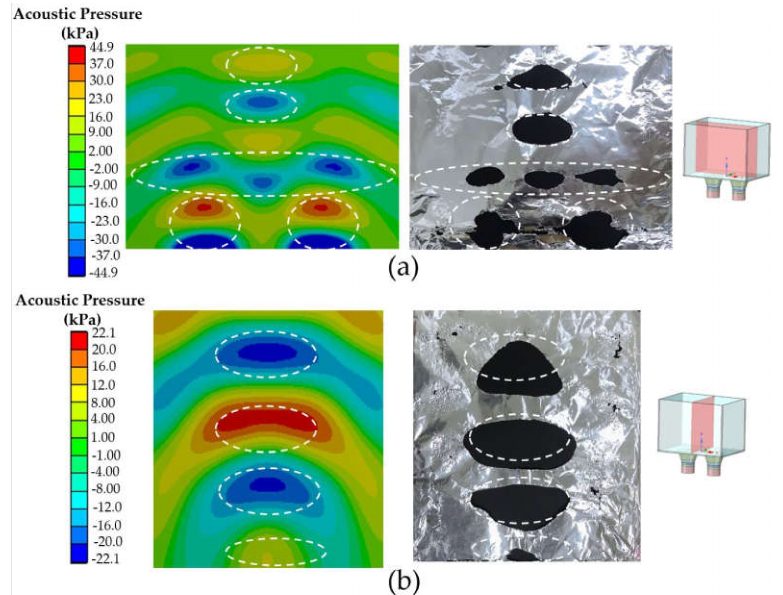
Figure 9. Comparison between the acoustic pressure distribution pattern (left) and foil corrosion (right) for ( a ) the xz plane and ( b ) the yz plane using acrylic as a tank